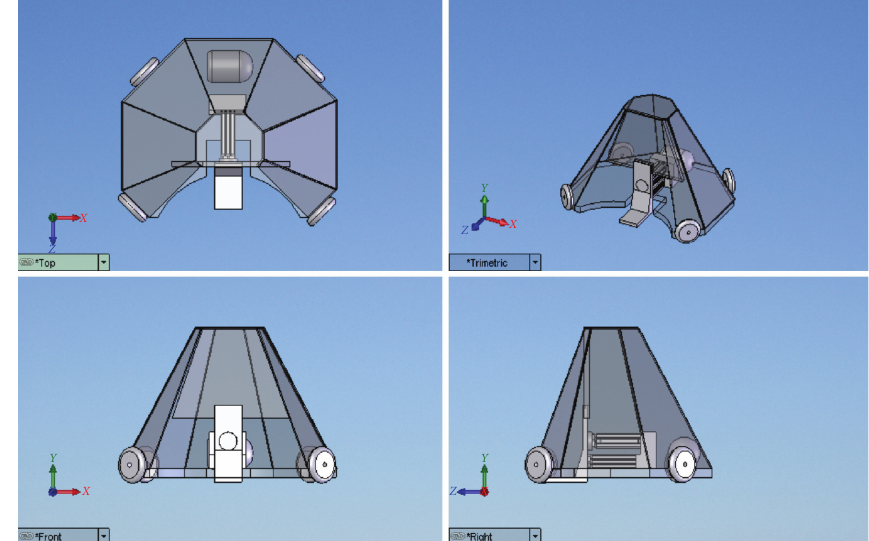
Figure 3: Conceptual design 2: Pyramid structure with a swing lift kicker.